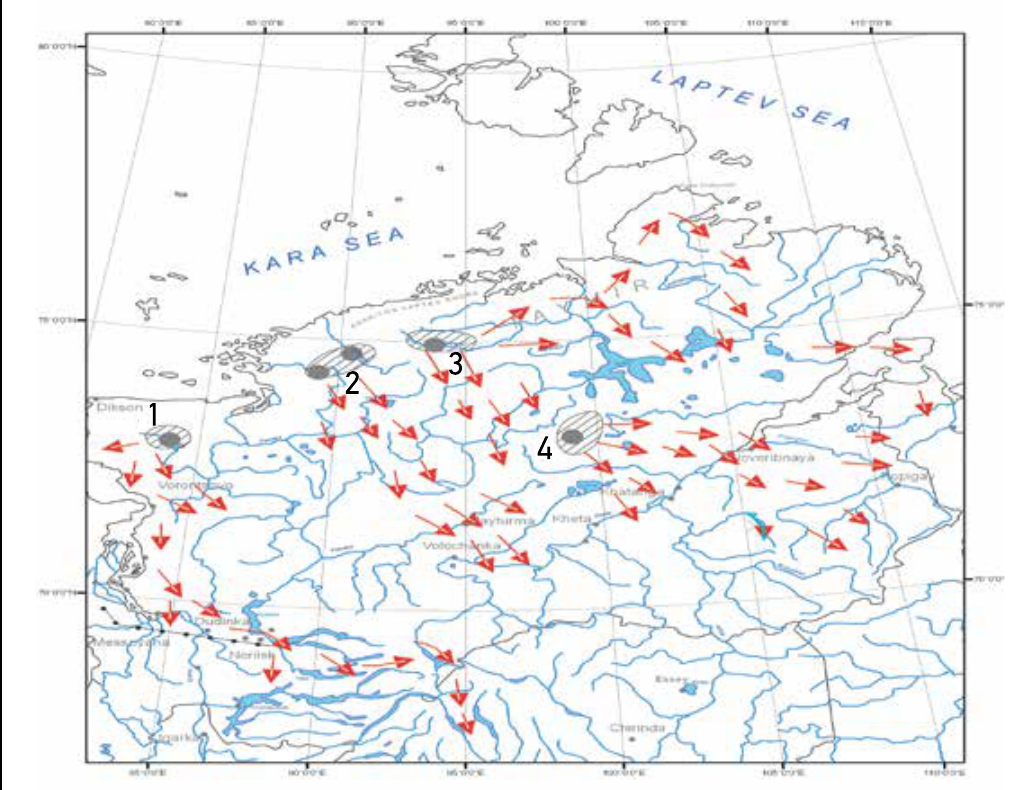
Fig. 3. Summer distribution and migration of Taimyr wild reindeer in